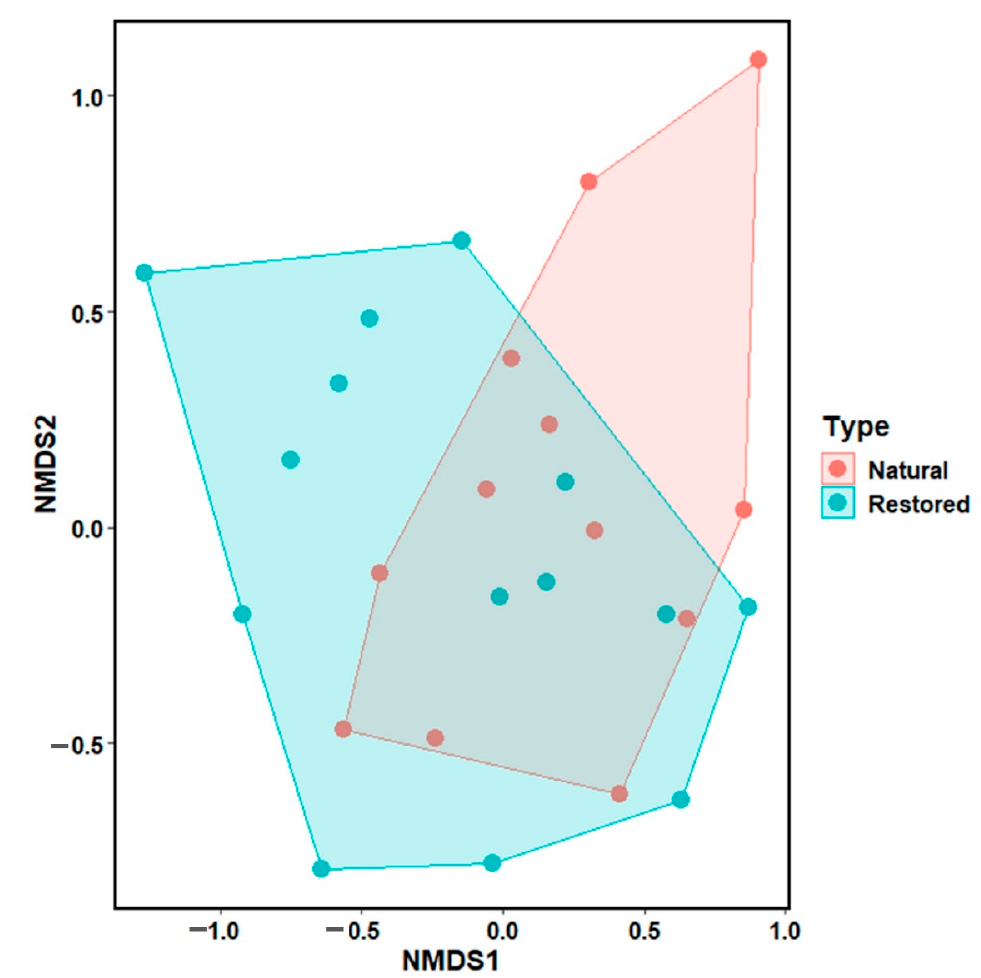
Figure 2. Non-metric multidimensional scaling (NMDS) scores for small mammal community composition from restored ( n = 14) and natural ( n = 12) wetland sites in West Virginia, USA, sampled from 2020–2021. Convex hulls surround restored wetland communities (blue) and natural wetland communities (pink). We specified 2 dimensions with 100 iterations. The distance matrix stress value was 0.19. Analysis of similarity indicates no significant difference in small mammal communities by wetland type (R = 0.032, p = 0.226).